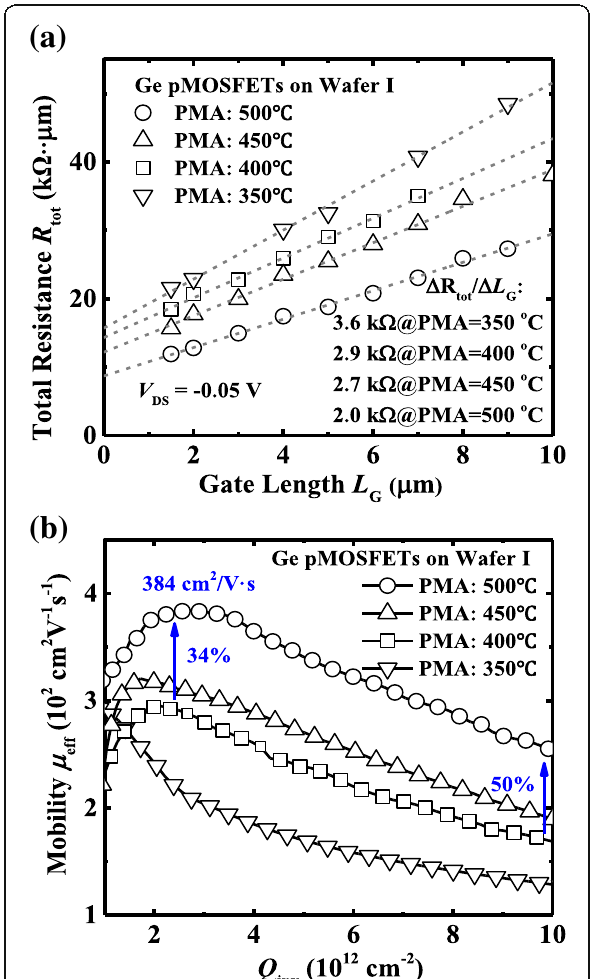
Fig. 5 a R tot as a function of L G at a V GS - V TH of − 1V and a V DS of − 0.05 V for devices on wafer I with various PMA temperatures. b μ eff vs. Q inv extracted by the split C - V method. The highest mobility is obtained in devices with a PMA at